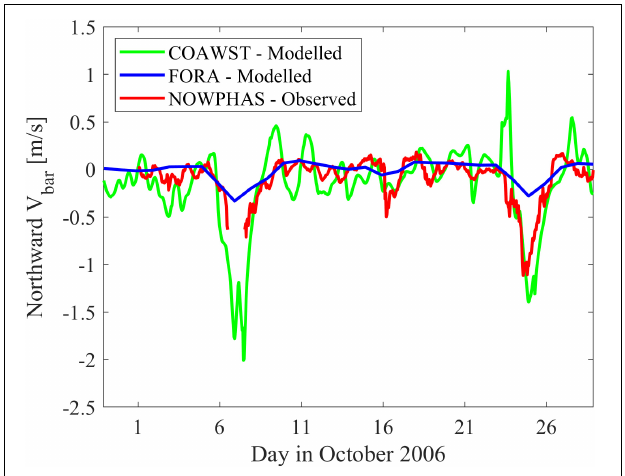
FIGURE 5 | Comparison of time series of vertically averaged velocity (North–South direction) among modeled and observed data in Kashima (green: COAWST model, blue: FORA model, red: NOWPHAS observed data).